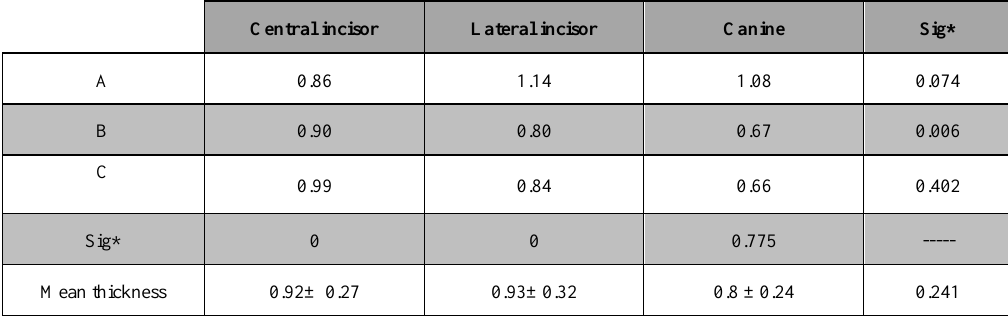
Table 3. Meanfacial plate thicknesses(mm)across measurement points per site.